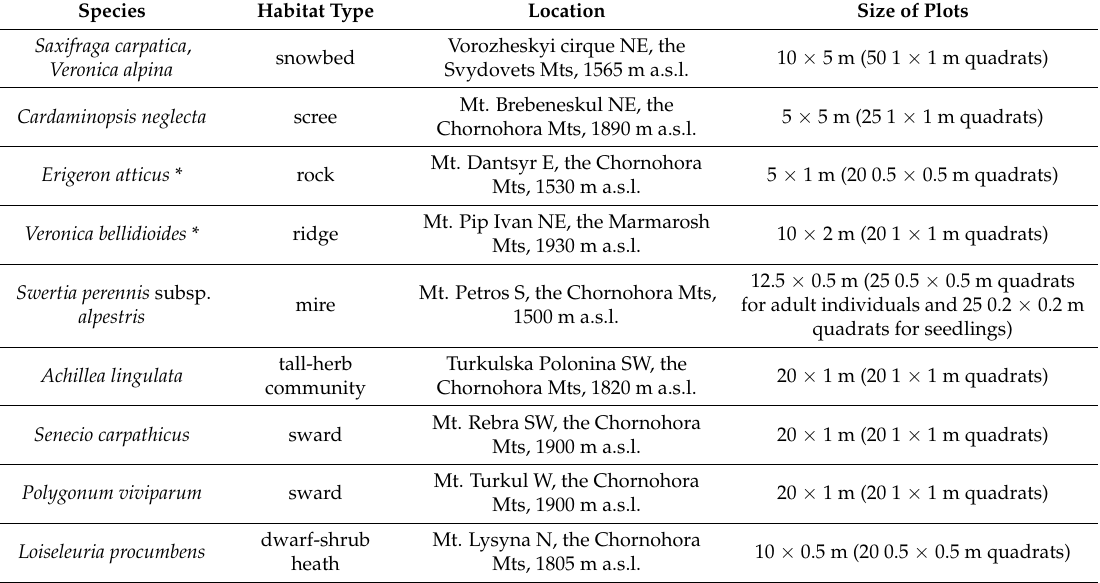
Table 1. Location and size of plots for monitoring populations of the studied